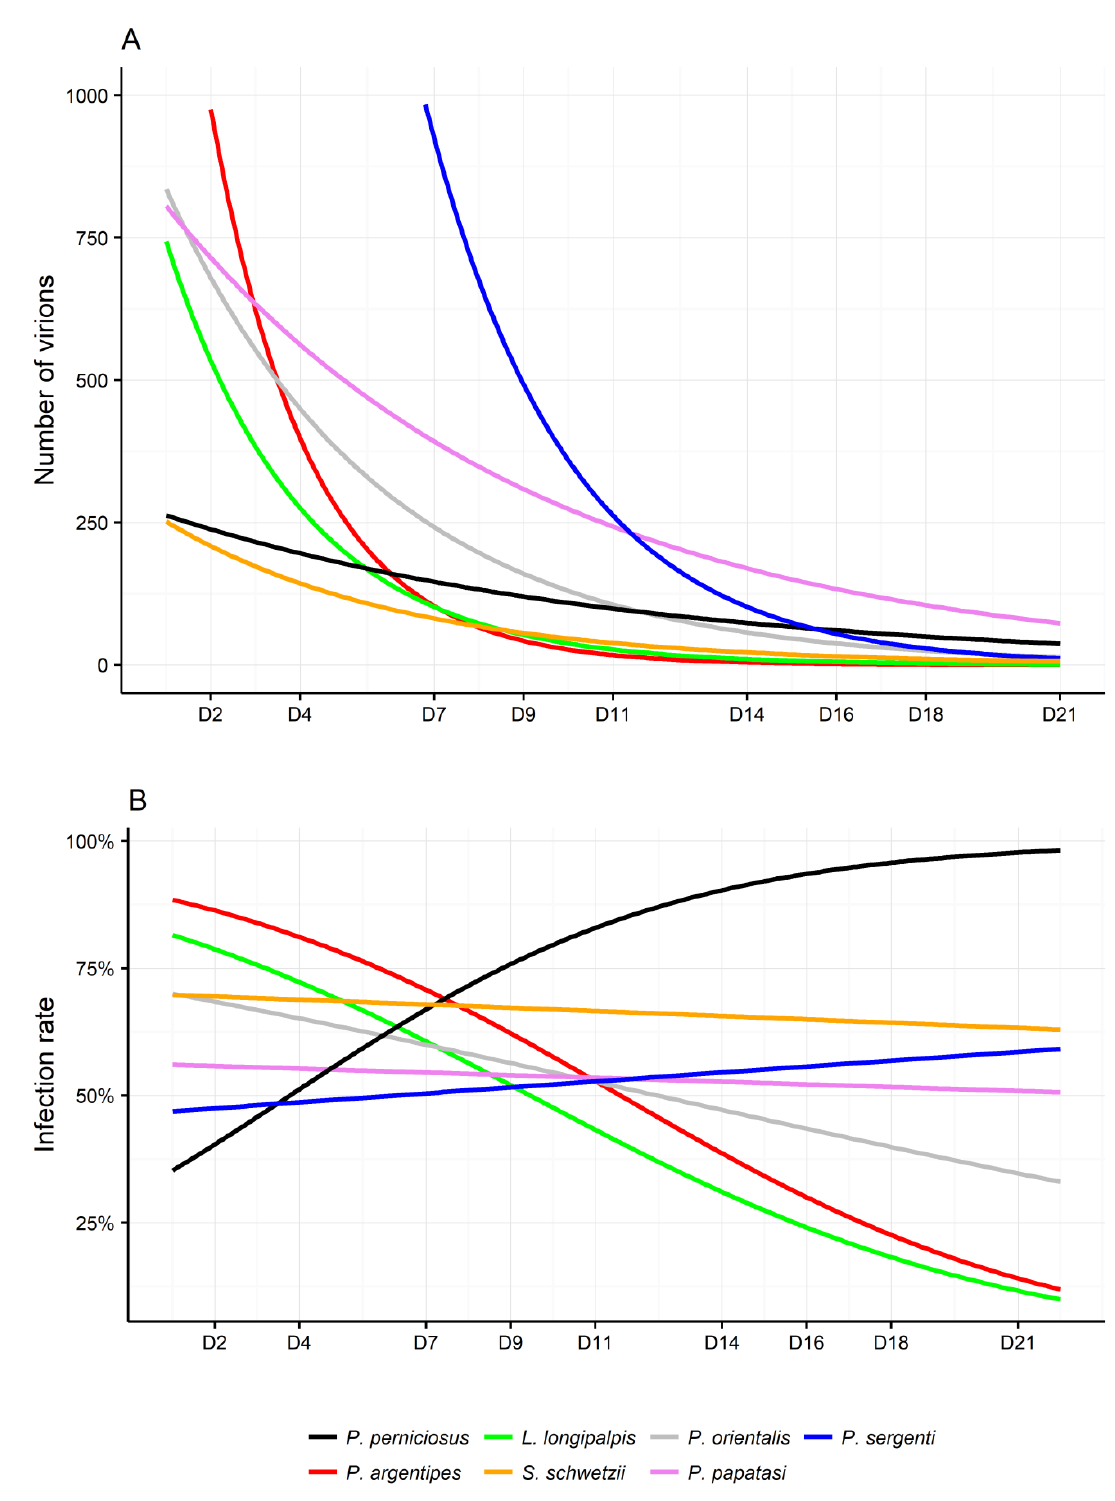
Figure 3. Fitted lines for ( A ) infection rate and ( B ) viral loads in phlebotomine females from different colonies. Fitted lines are calculated from the original data (Table S4) according to models with ( A ) quasi-poisson and ( B ) quasi-binomial distribution. P. , Phlebotomus; L., Lutzomyia; S., Sergentomyia.